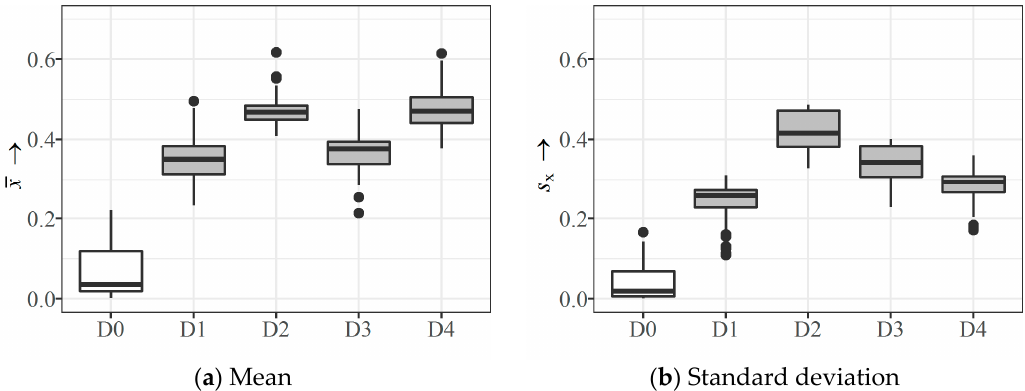
Figure 7. Features of the emission profiles for the first classifier support vector machine (SVM)-1 to distinguish class D0 and classes (D1, D2, D3, D4).